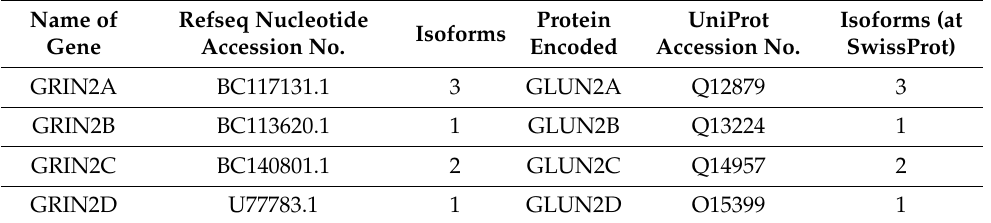
(Table 1). The aliphatic index, instability index, molecular weight, hydropathicity, and theoretical pI values of UGPase were calculated using ProtParam [39]. Table 1. The Human N-methyl D-aspartate (NMDA) Glutamate receptor sequences were obtained from the NCBI Refseq nucleotide and protein database and their isoforms.